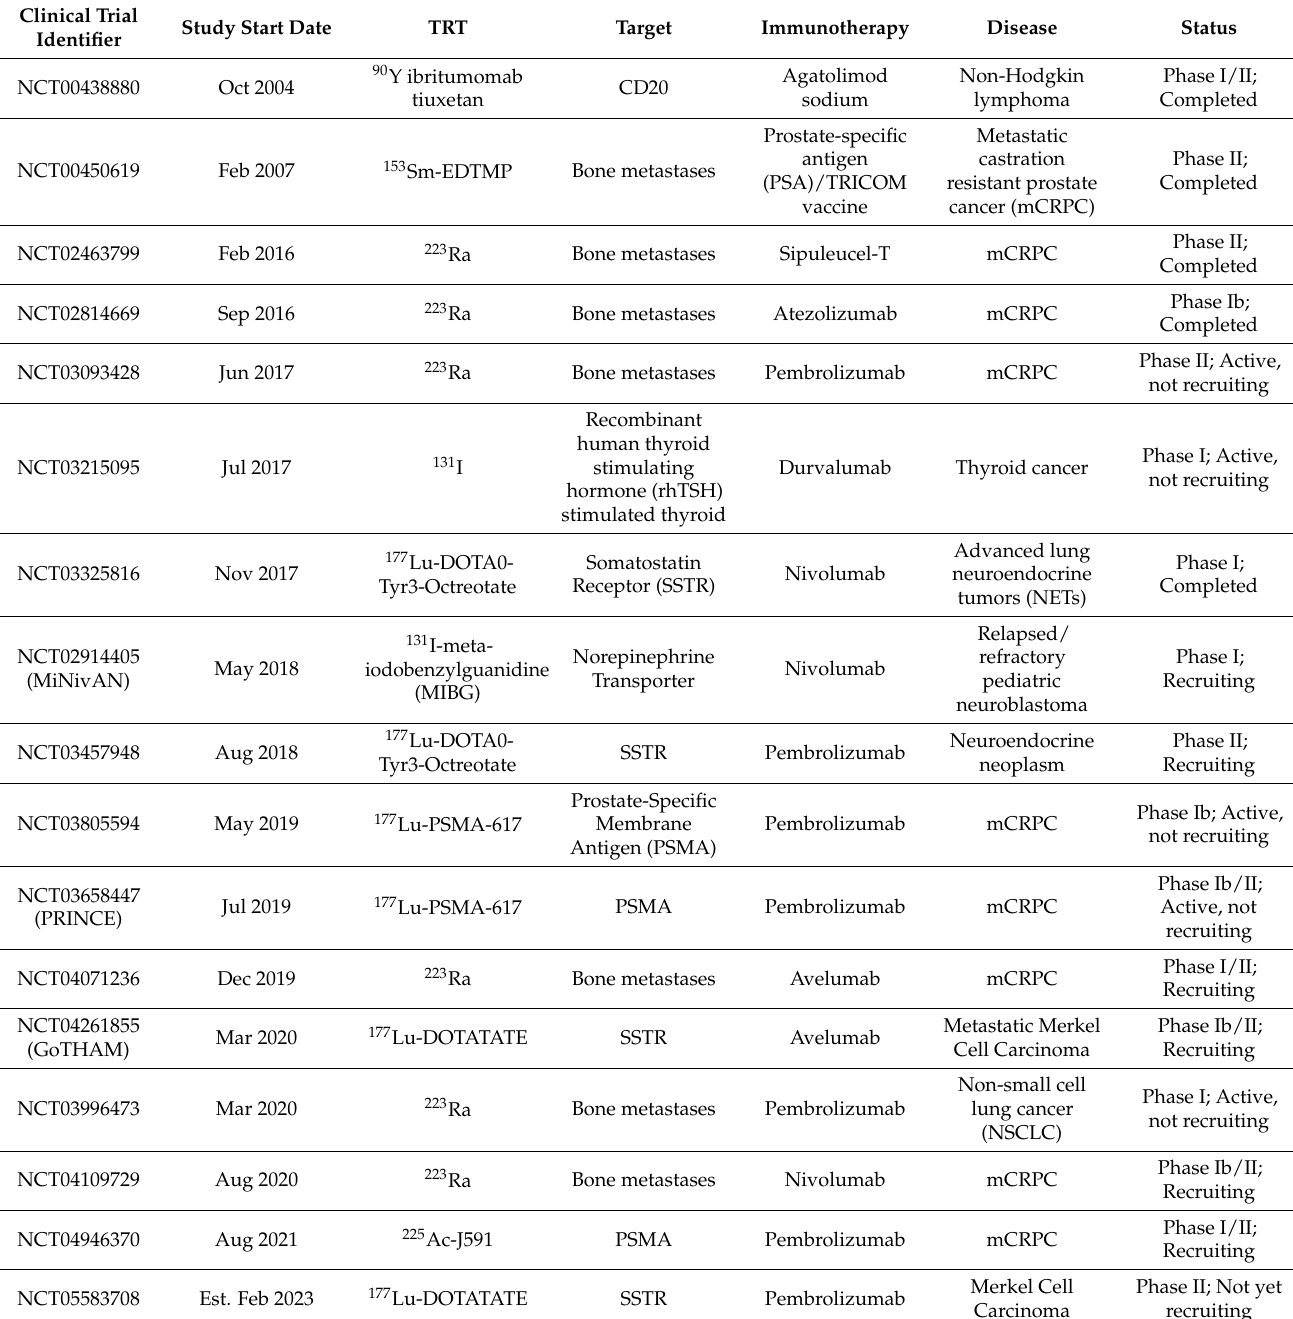
Table 2. Clinical Trials of Combination Targeted Radionuclide Therapy